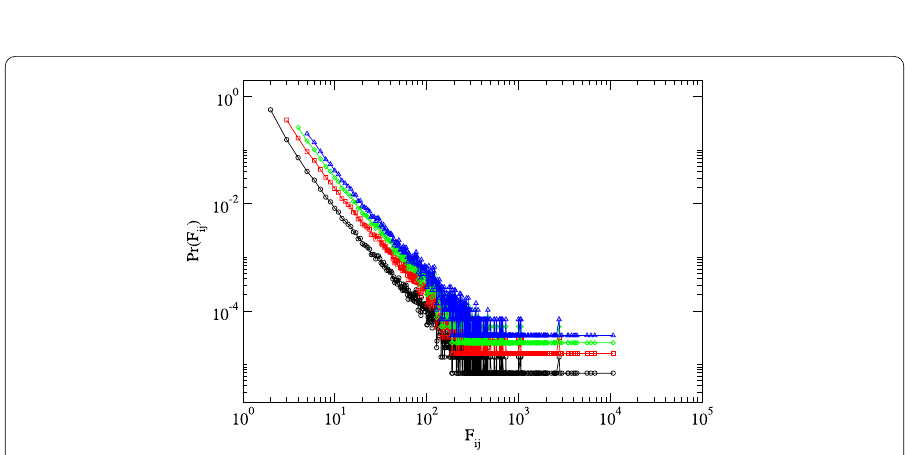
Figure 16 Distributions of flow weights Pr( F i , j ) through node pairs of the networks created by applying the threshold criterion W = 2 (black ◦ ), W = 3 (red (cid:3) ), W = 4 (green ♦ ), and W = 5 (blue (cid:23) )